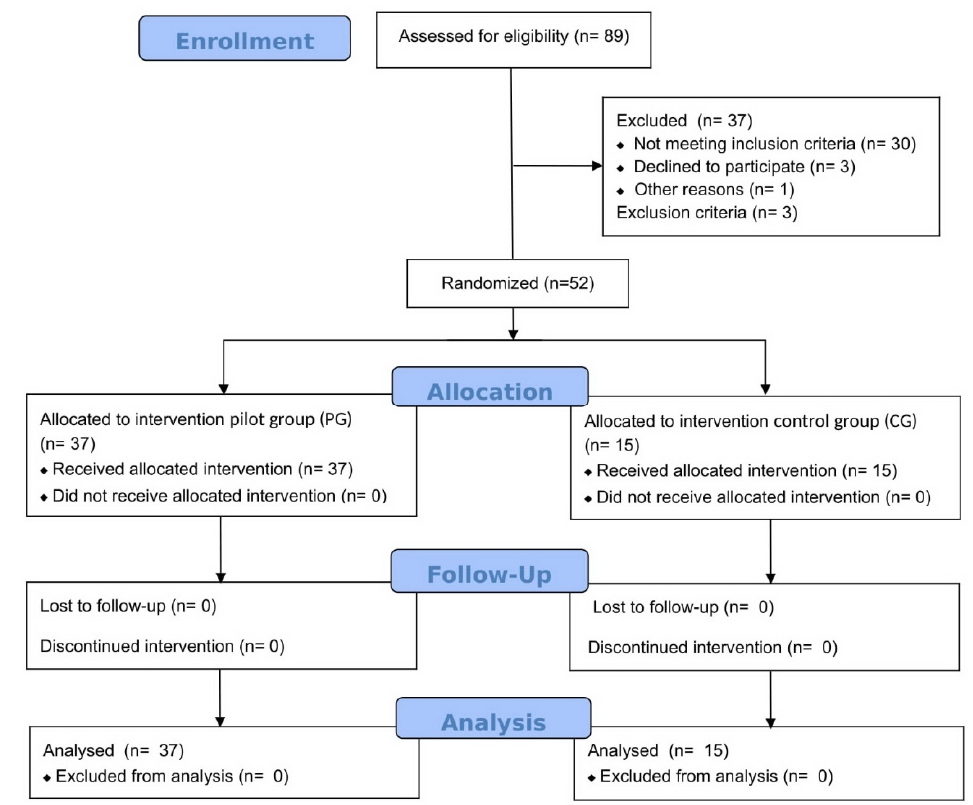
Figure 1. The CONSORT flow diagram of the progress through the phases of a randomized trial of two groups (enrolment, intervention, follow-up, and data analysis).